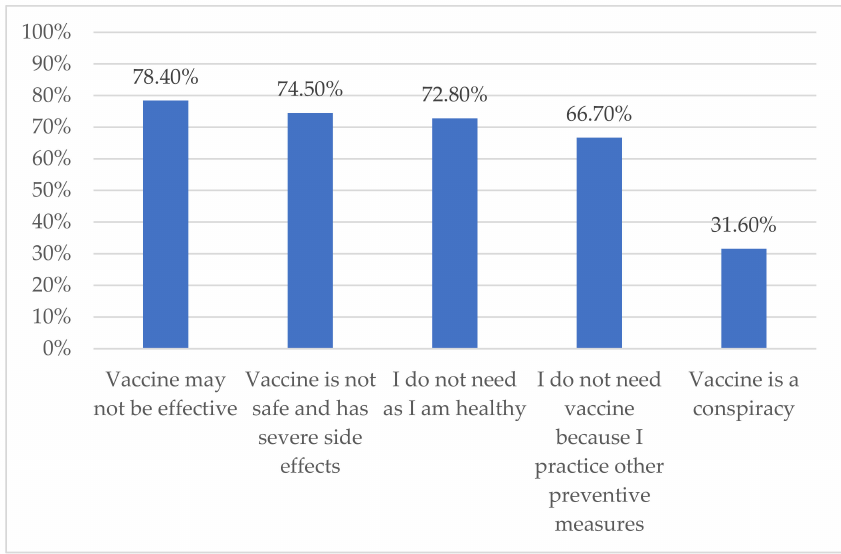
Figure 1. Reasons for rejecting COVID-19